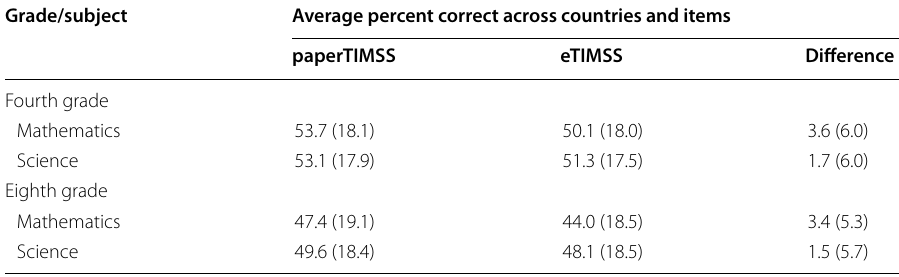
( ) Standard deviations appear in parentheses. Standard deviations of item percent correct were computed across items in each country and then pooled across countries. Because of rounding some results may appear inconsistent